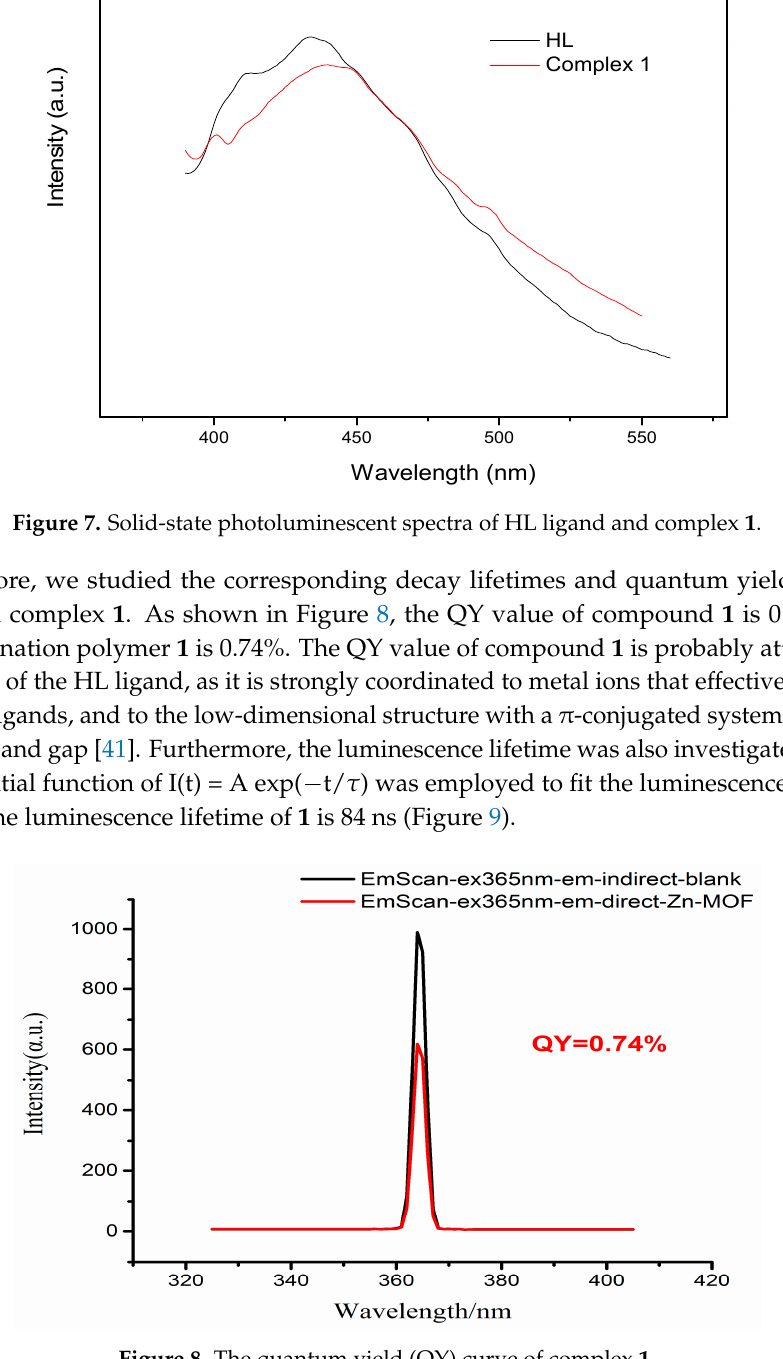
Figure 8. The quantum yield (QY) curve of complex 1 .